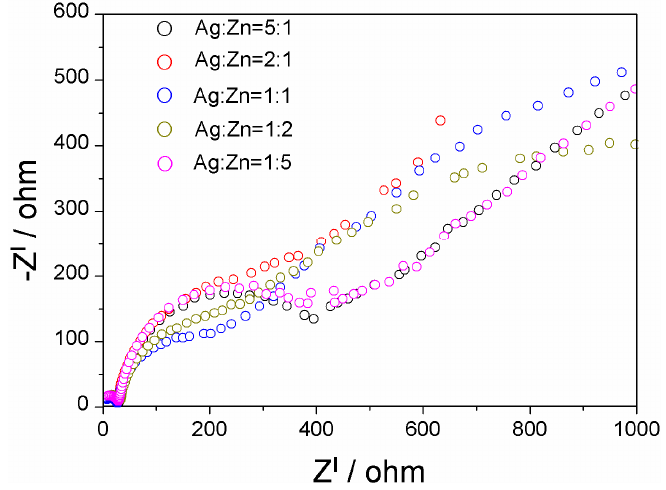
Figure 5. Nyquist plots of electrochemical impedance spectra (EIS) of the as-prepared samples (AgInS 2 - x Ag 2 S- y ZnS- z In 6 S 7 ). The EIS measurements were performed in the presence of a 2.5 mM K 3 [Fe(CN) 6 ]/K 4 [Fe(CN) 6 ] (1:1) mixture as a red-ox probe in 0.5 M Na 2 SO 4 aqueous solution.